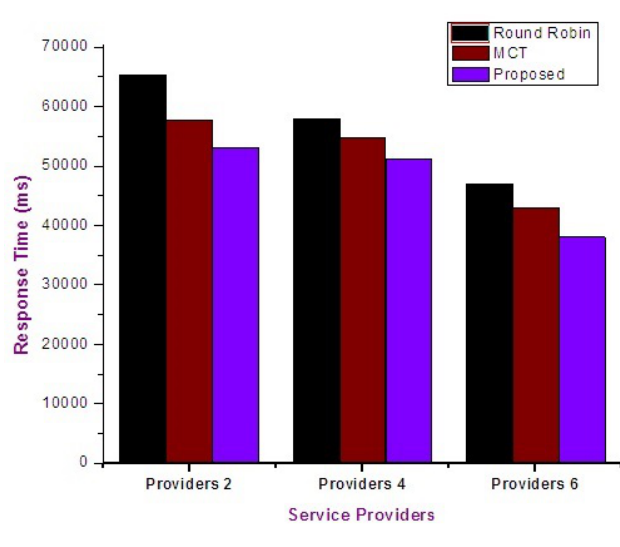
Figure 20. Response